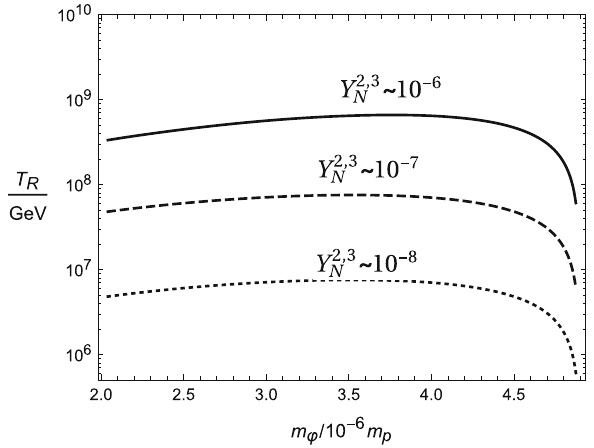
whereas the dotted blue line is for the original field φ . In the right panel we plot the corresponding slow-roll parameters (cid:20), η versus N . Inflation ends when (cid:20), η = 1. For both plots, we have taken μ = 1 . 12 m P